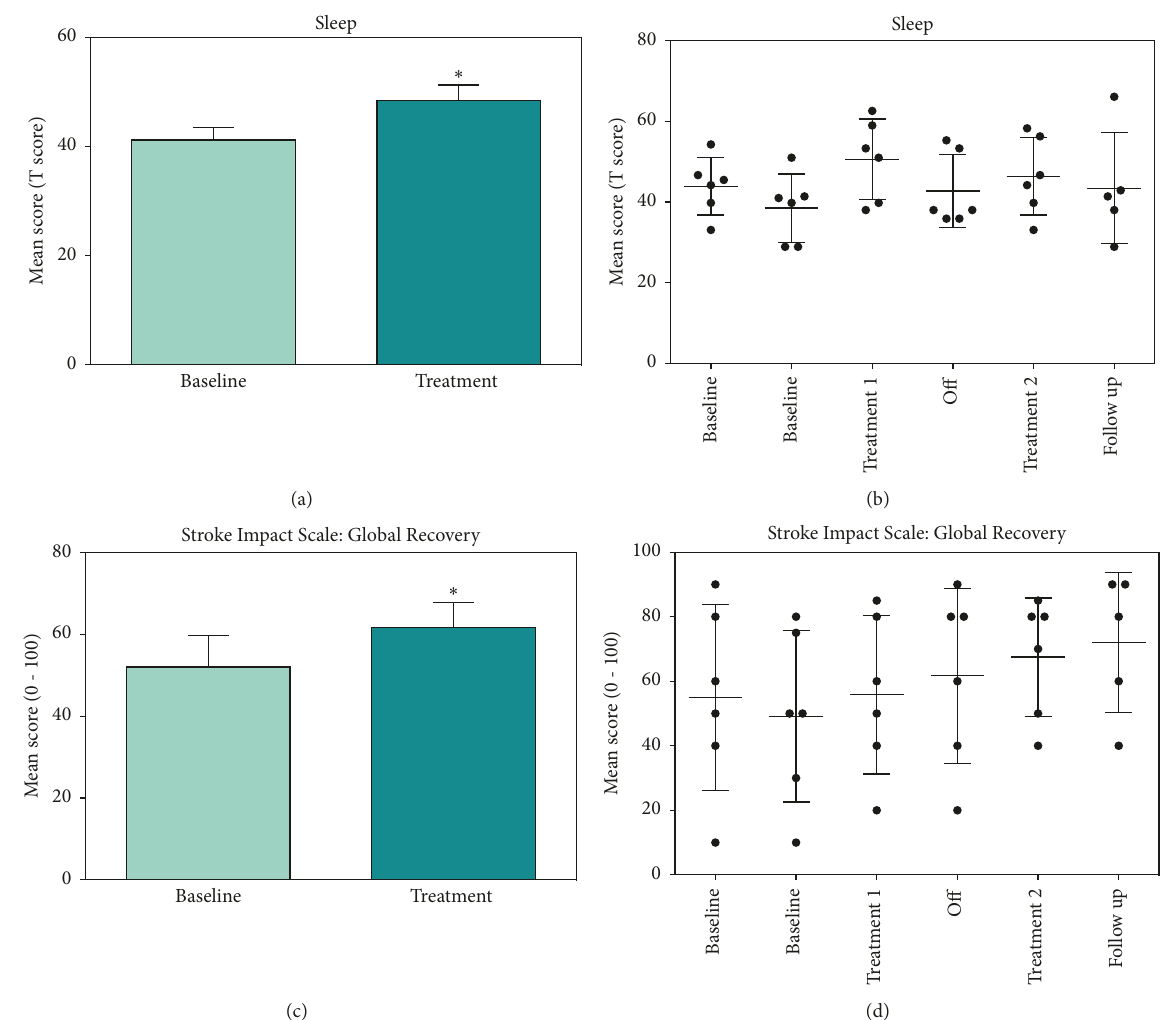
Figure 3: Effect of HBOT on Quality of Life: participants reported significant improvement in sleep (a & b) and overall global recovery (c & d) following HBOT. Graphs (a) and (c) represent the difference between baseline and treatment and (b) and (d) show all individual data